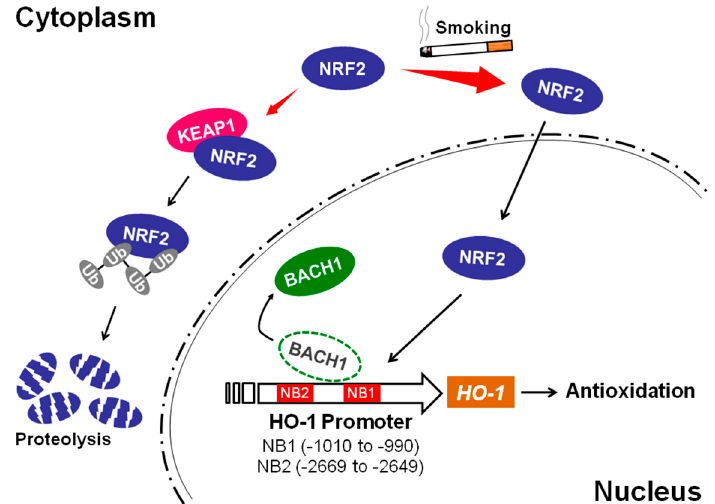
Figure 7. The schematic diagram of smoke-mediated HO-1 induction. Under stress-free conditions, NRF2 is associated with KEAP1 and undergoes proteolysis. Upon exposure to cigarette smoke, NRF2 is dissociated from KEAP1 and translocated into nucleus. Nuclear NRF2 competes with BACH1 for binding to the HO-1 promoter ARE sites, leading to HO-1 transcription and antioxidant activity.